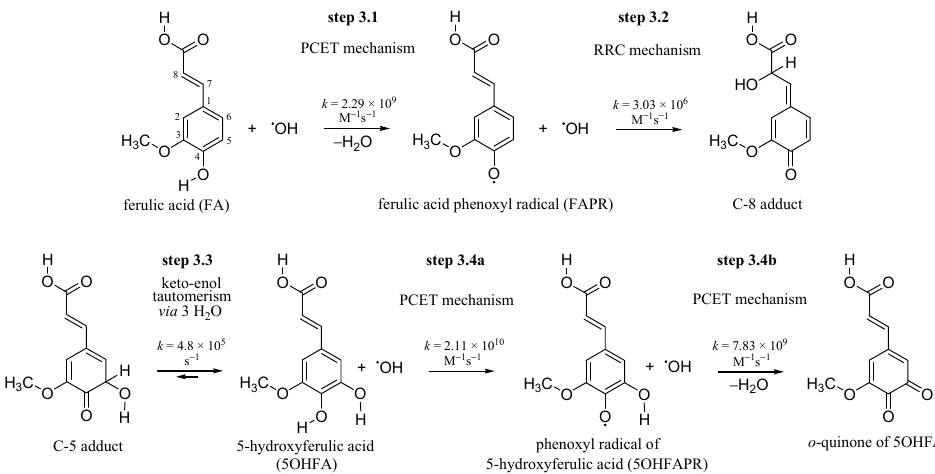
Figure 1. Presumed steps of fate of ferulic acid under • OH radicals attacks. Kinetic data are obtained using the M06-2X/6-311++G(d,p) level of theory in the gas-phase.